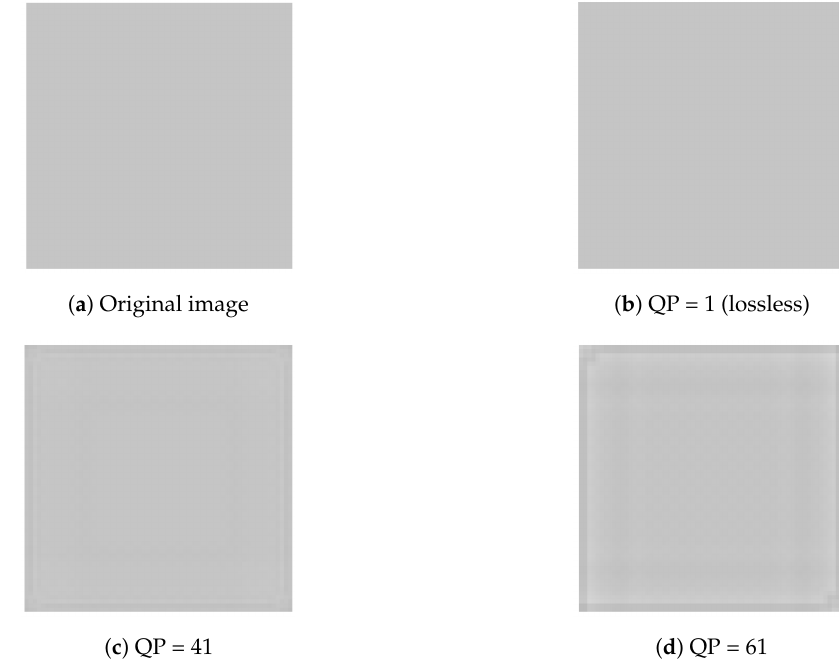
Figure 1. Part 1. Chequerboard block artefacts. QP, Quantization